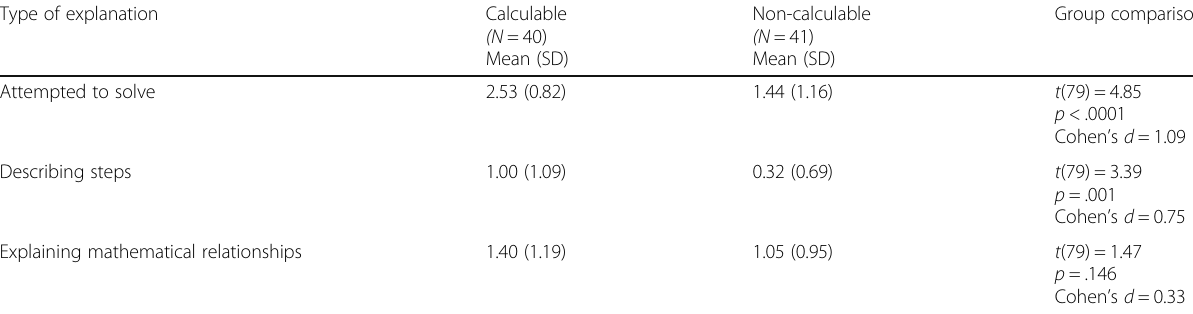
Table 2 Average number of explanations of each type by group (study